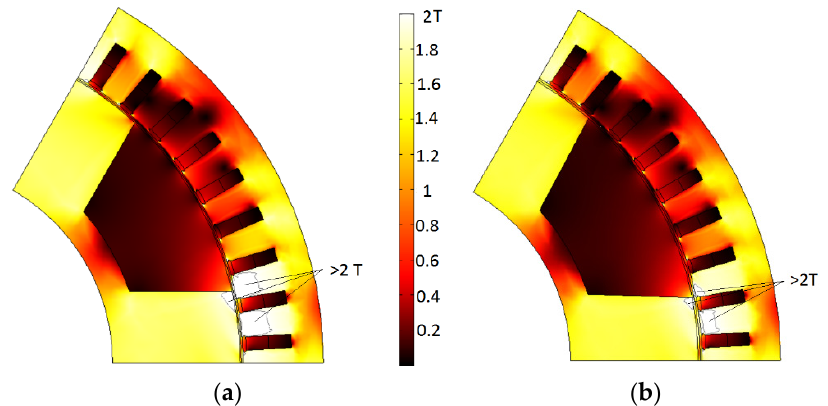
Figure 5. SHM geometry and flux density magnitude; black contours mark the regions in which the magnitude of the flux density vector exceeds 2 T (extreme saturation): ( a ) before optimization; ( b ) after optimization; it can be seen that after optimization, the regions in which the flux density exceeds 2 T have noticeably decreased.